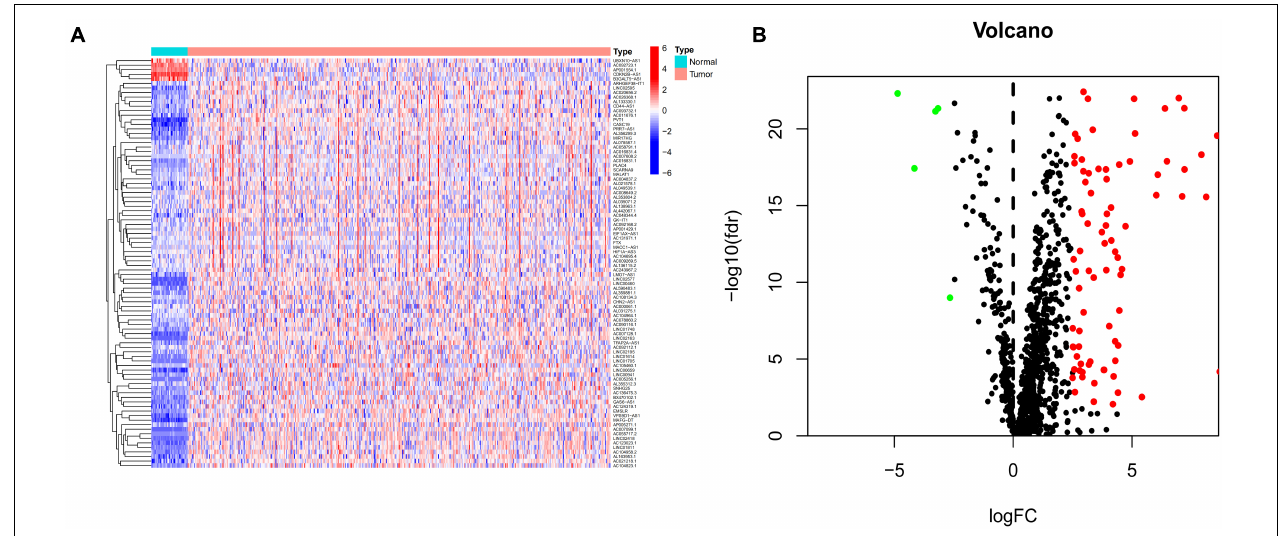
FIGURE 1 | Identification of differentially expressed immune-related lncRNAs (DEirlncRNAs) using TCGA datasets (A,B) The heatmap (A) and volcano plots (B) are shown.